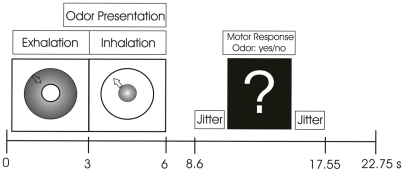
Trial time course.In the beginning of each trial, participants were requested to exhale (a ball decreased in diameter for 3 s) and then to inhale (a ball increased in diameter for 3 s). After a variable interval (range = 2.6–8.5 s) a question mark appeared on the screen and the participants were asked to indicate whether they perceived an odor or not. By pressing one of the two response buttons the questions mark disappeared. If no response was given within 2.75 s, an exclamation mark appeared for 0.5 s. The trial duration was 22.75 s.